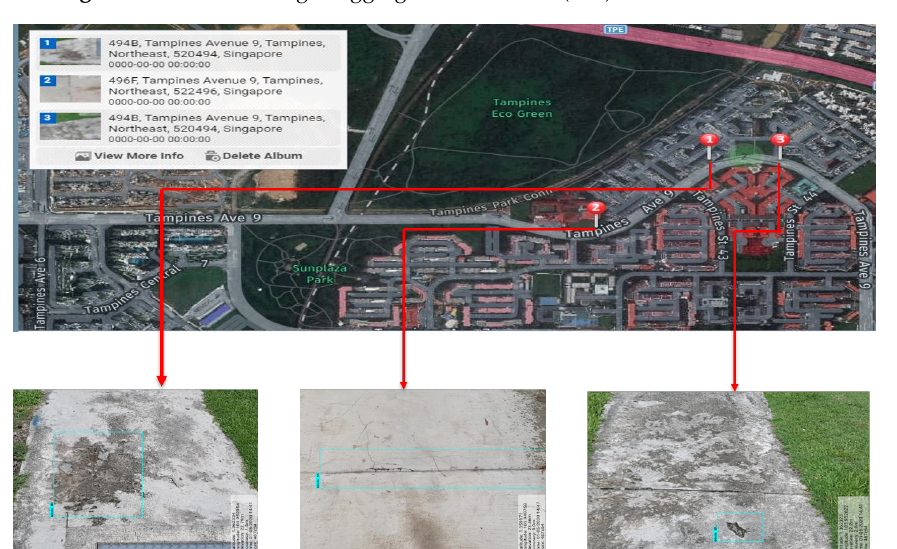
Figure 12. Defects with geotagging information in ( a – h ).